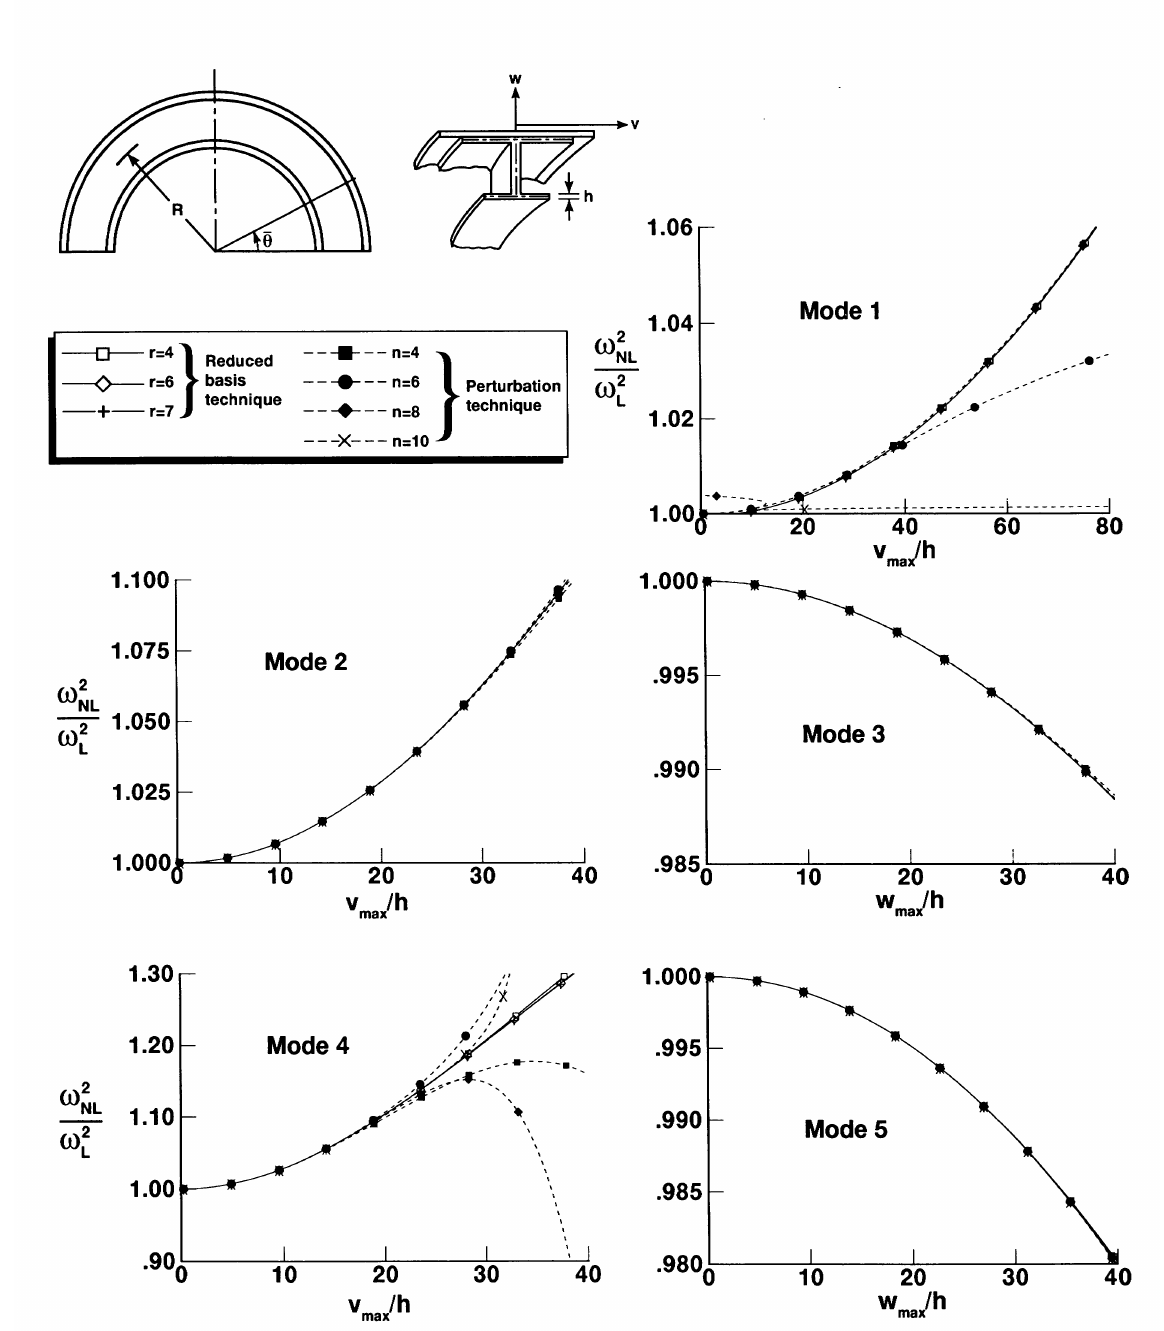
FIGURE 2 Convergence of nonlinear frequencies obtained by reduced basis and pertur bation techniques. Thin-walled composite frame with I cross section (see Fig.